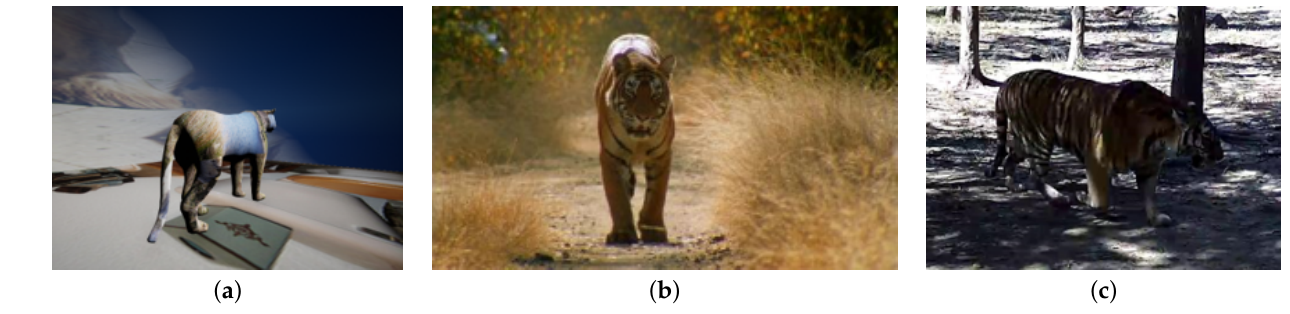
Figure 6. Example images in ( a ) SA-Tiger, ( b ) TD-Tiger, and ( c )